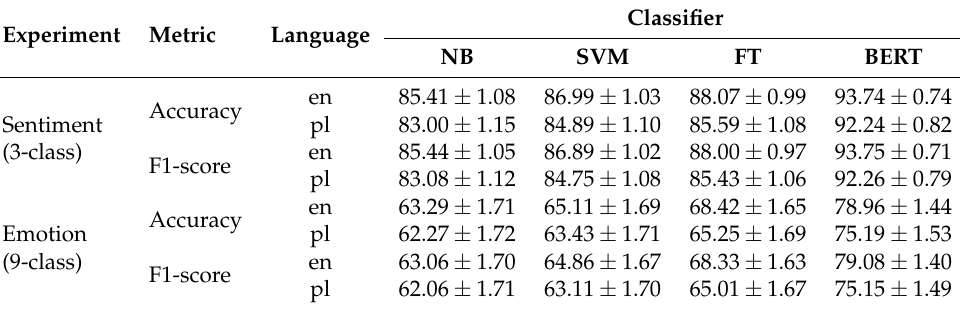
Table 2. Results of experiments (in percentages) on sentiment and emotion recognition for English and Polish versions of the corpus for test subset. Confidence intervals given for confidence level